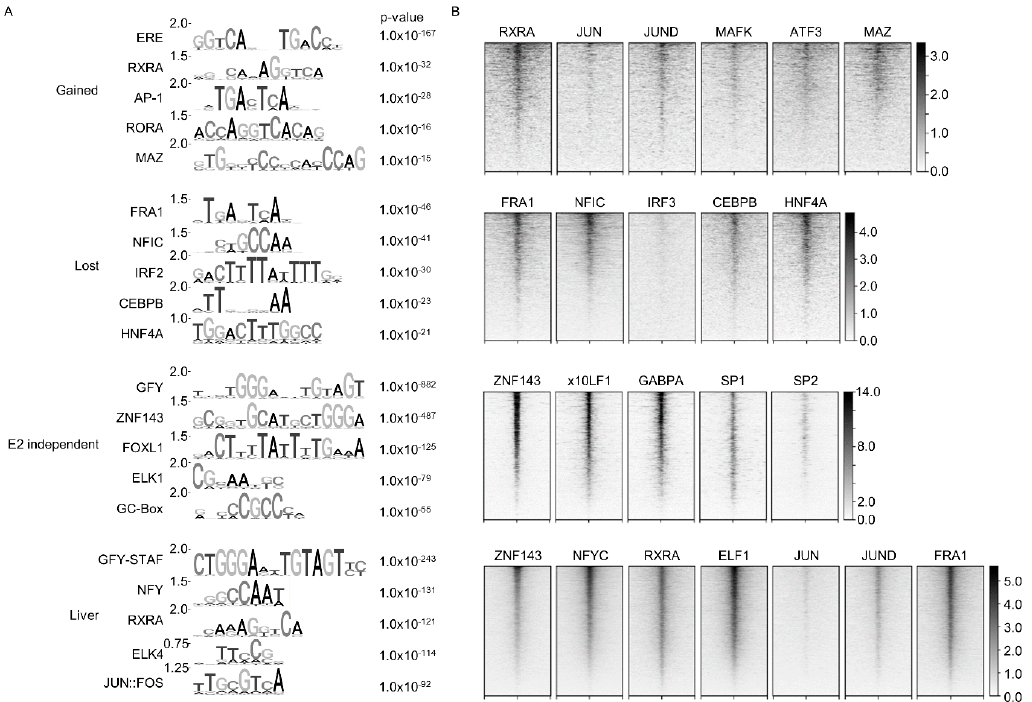
Figure 3. Motif enrichment and colocalization of transcription factors with ESR1 peaks. ( A ) The top five motifs in each sample are shown. The top bit value score is indicated to the left of each motif diagram. The p-value indicates enrichment of the motif compared to background. ( B ) Heatmaps showing ChIP-Seq read density centered on ESR1 peaks within a ± 5 kb window. TF ChIP-Seq data were obtained from published datasets conducted in HepG2 cells. Darker intensity indicates higher enrichment, as indicated by the legends to the right of the